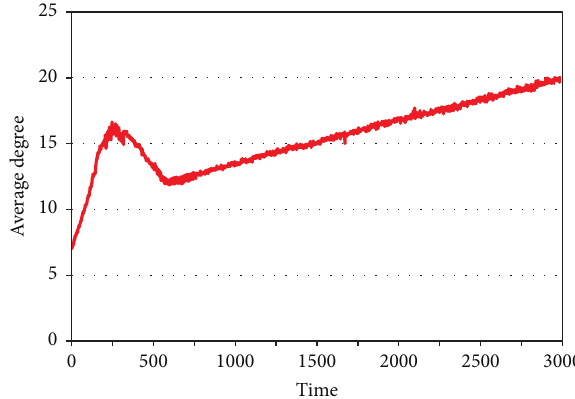
Figure 5: Average payoff of individuals of the proposed complex network.